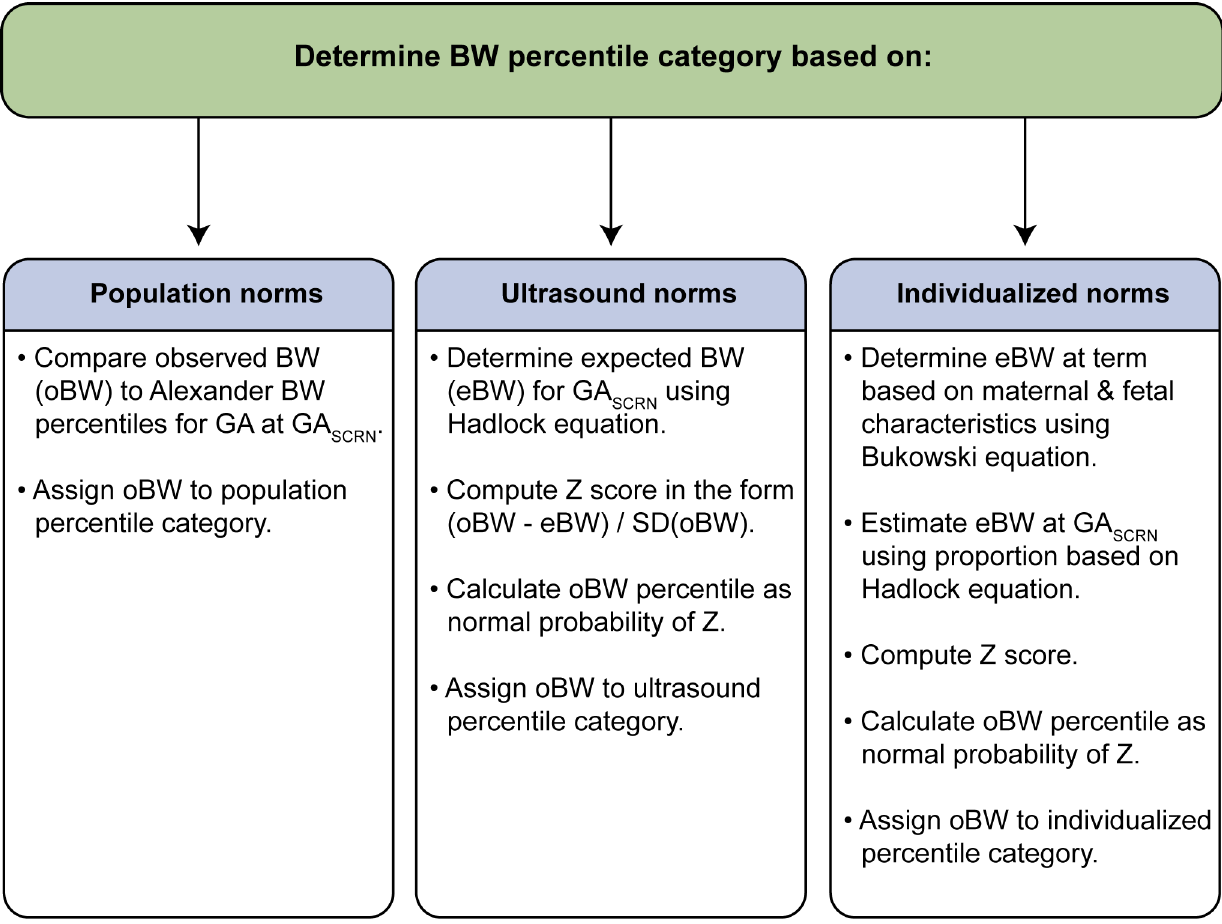
Figure 1. Summary of steps used to assign infants to a birth weight percentile category. GA SCRN is the fetal age at death (for stillbirths) or delivery (for live births) estimated by the SCRN algorithm [17]. BW, birth weight; SD, standard deviation. References: Alexander et al. [18], Hadlock et al. [19]; Bukowski et al. [15].